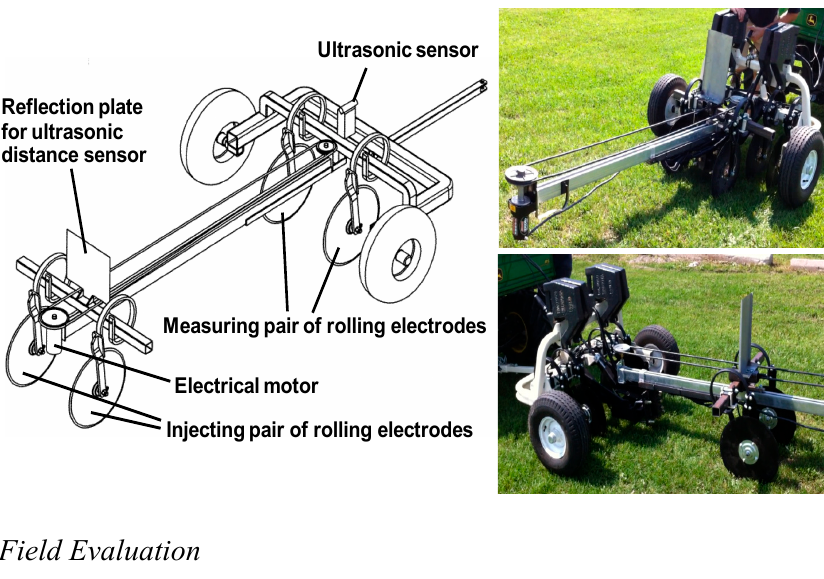
Figure 3. Prototype galvanic contact resistivity scanner.